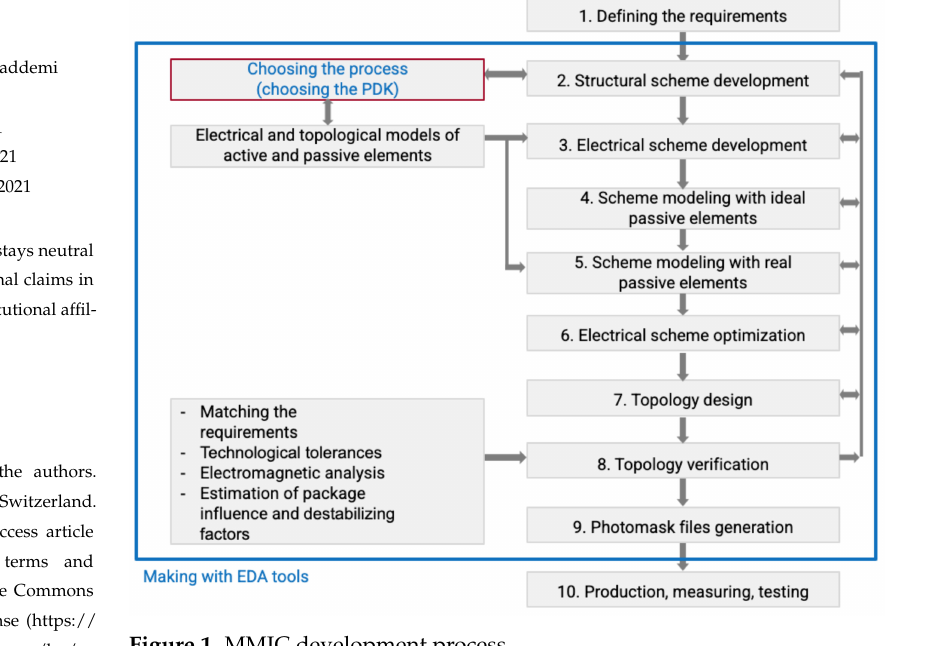
Figure 1. MMIC development